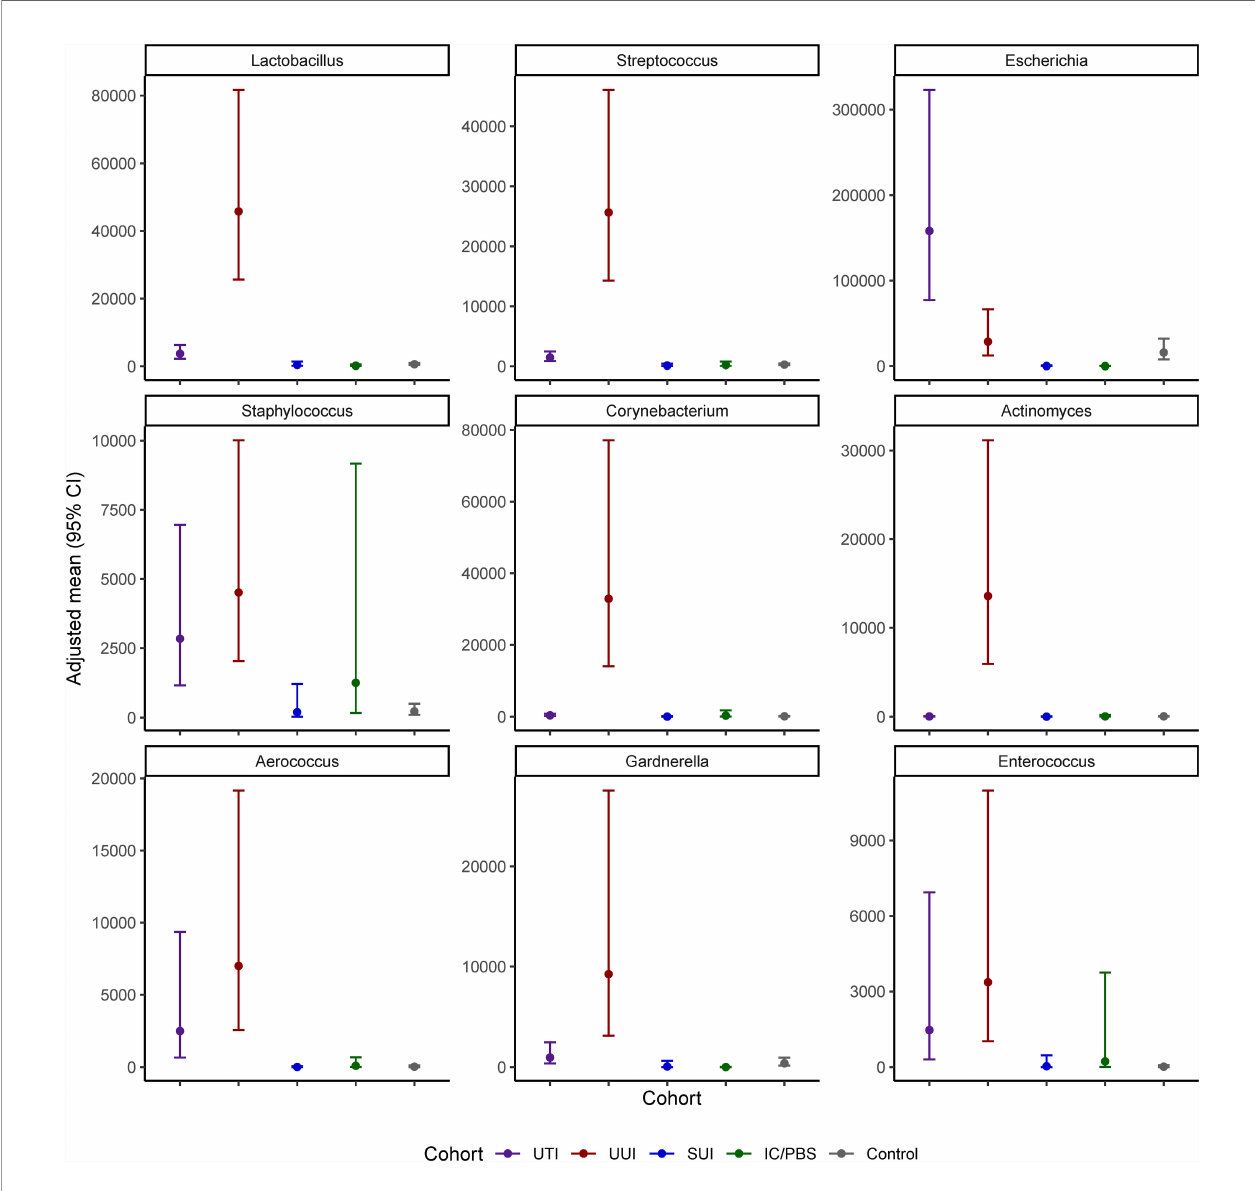
FIGURE 2 | Age adjusted mean abundance (CFU/mL) with 95% con fi dence interval by cohort.